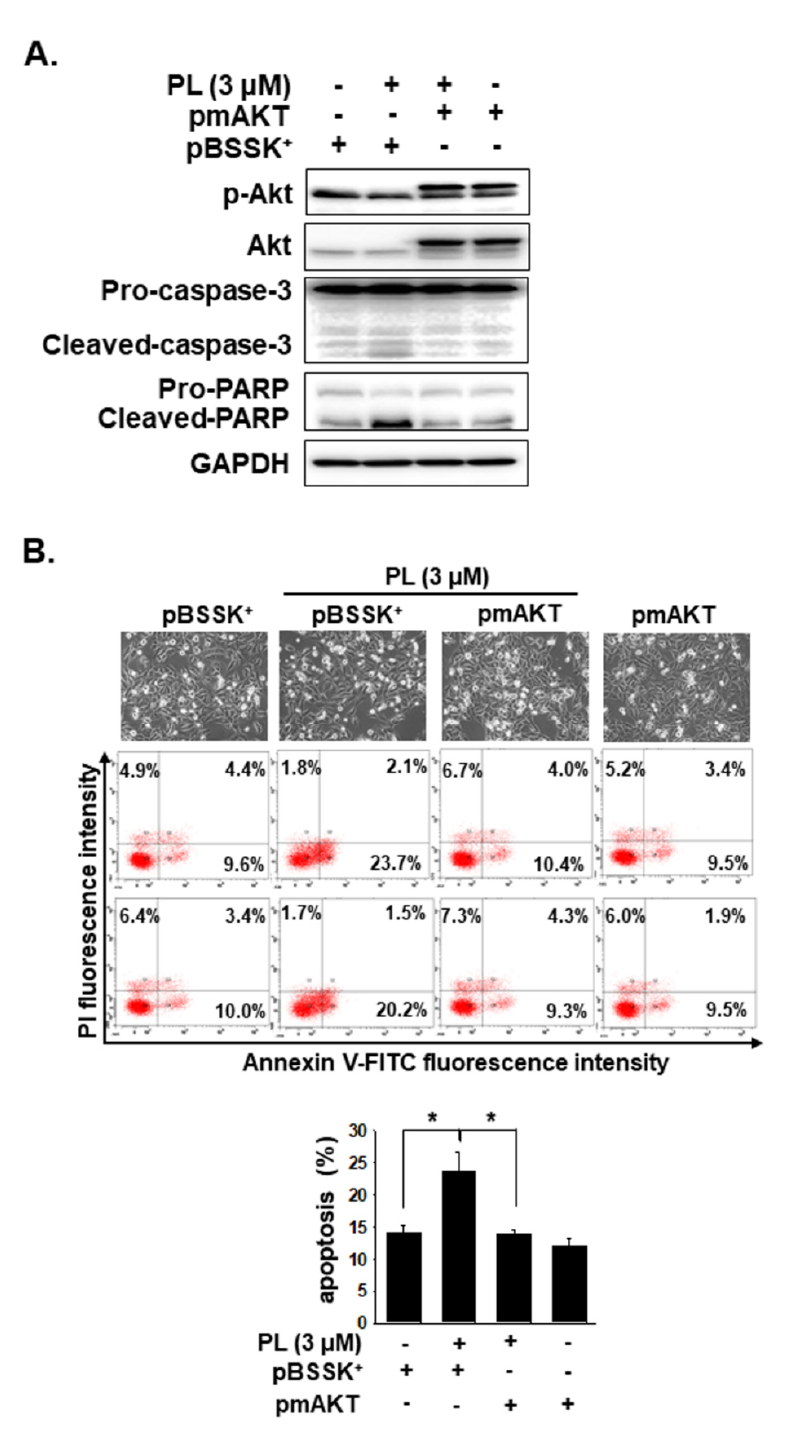
Figure 7. Piperlongumine (PL) induced cellular apoptosis through the Akt signaling pathway. KMH-2 cells were used to verify the involvement of the Akt signaling pathway in PL-caused apoptosis. ( A ) KMH-2 cells were transfected with or without constitutively active Akt construct, and the expression and the activation of Akt, caspase-3, and PARP were investigated by western blots after incubation with PL for 24 h. ( B ) Cellular apoptosis was investigated by flow cytometry. pBSSK + was used as a negative control of transfection. pmAKT was a constitutively active form of the ATK construct. DMSO was used as a negative control. GAPDH was used as a loading control. Three independent experiments each for western blotting and flow cytometry were conducted, and the western blots and flow cytometry dot plots of a representative experiment are shown. *indicates p < 0.05.